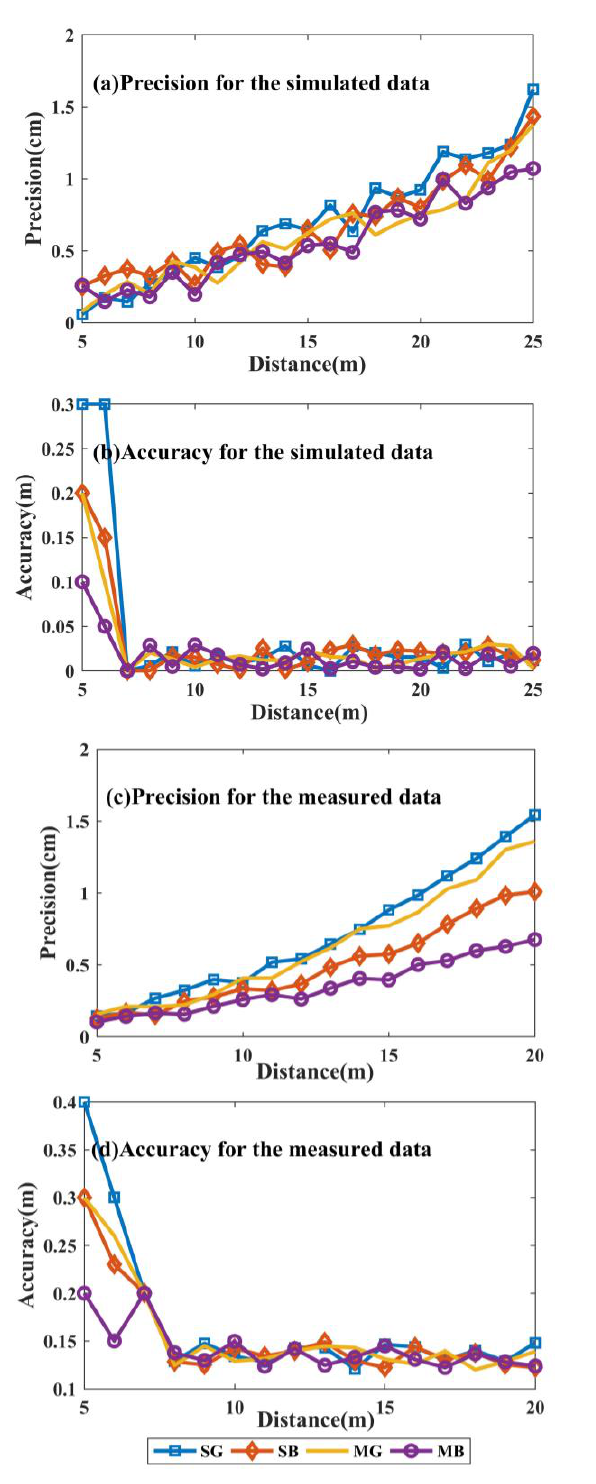
Figure 1. Precision and accuracy comparison of four methods for the simulated and measured waveforms. SG, SB, MG, and MB stand for Gaussian function, B-spline-based model, the multispectral waveform decomposition model based on Gaussian function, and the proposed method.